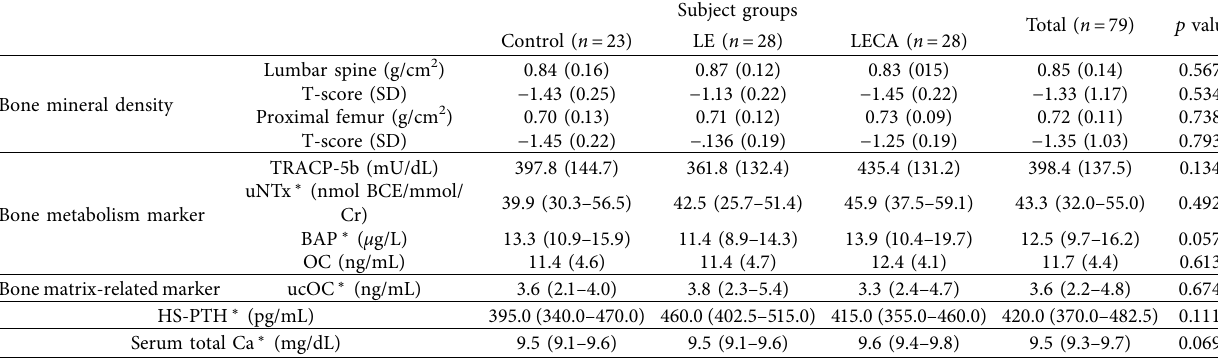
Table 3: Measurements before starting